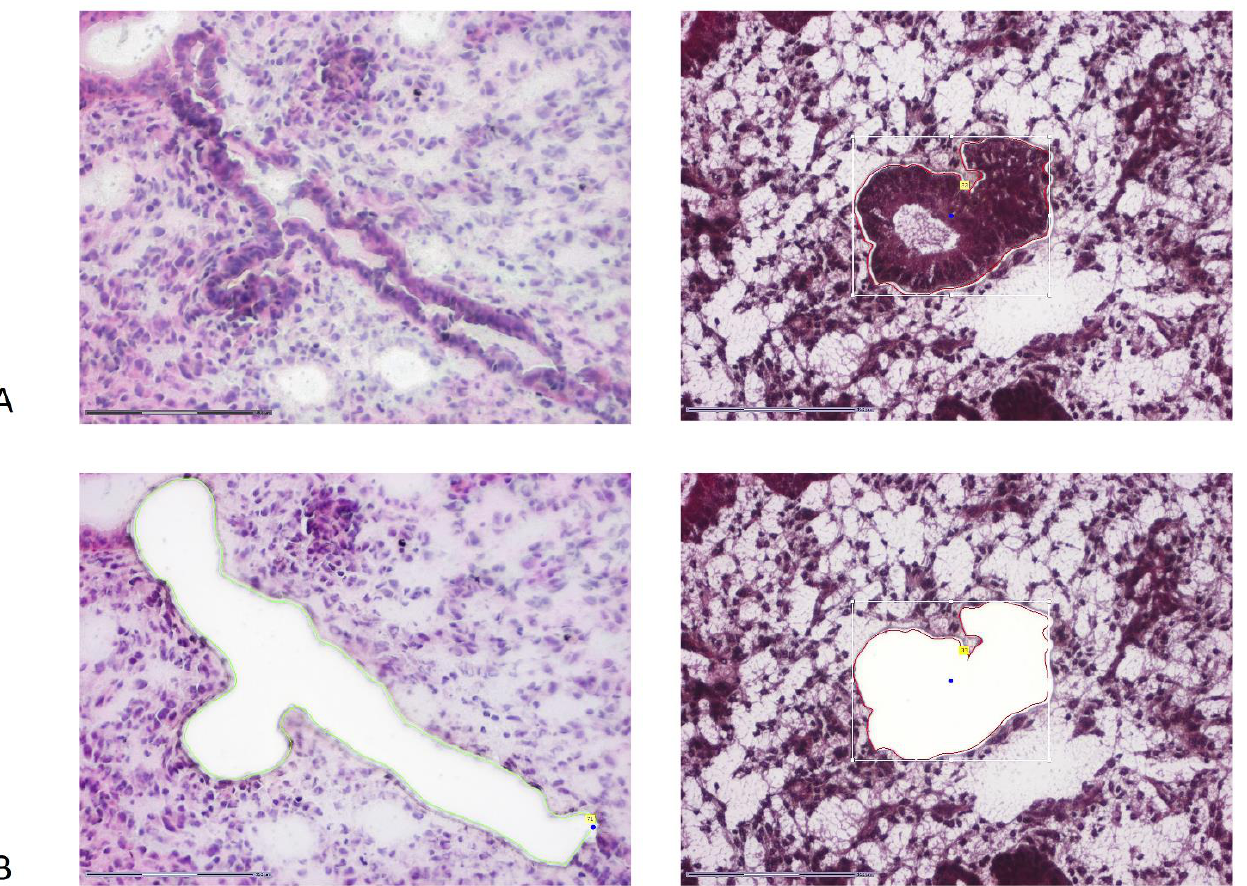
Figure 1. A single representative endometrial gland before ( A ) and after ( B ) laser microdissection from 8 µ m tissue slice. For a demonstration of gland mapping, eosin and hematoxylin staining was used on this sample (on the left). For DNA extraction, sections were stained with hematoxylin only (on the right).